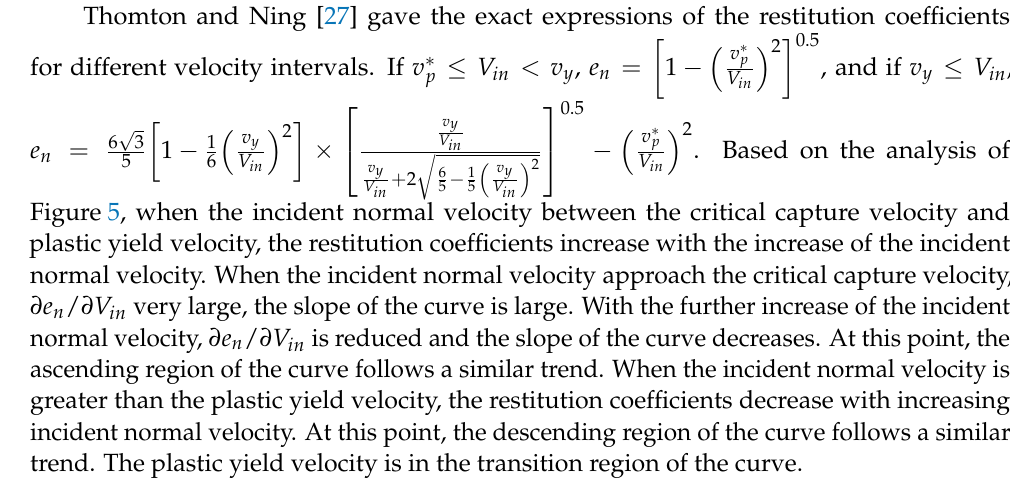
Table 2. Basic physical properties of coal ash particles and flat surface. Serial Number